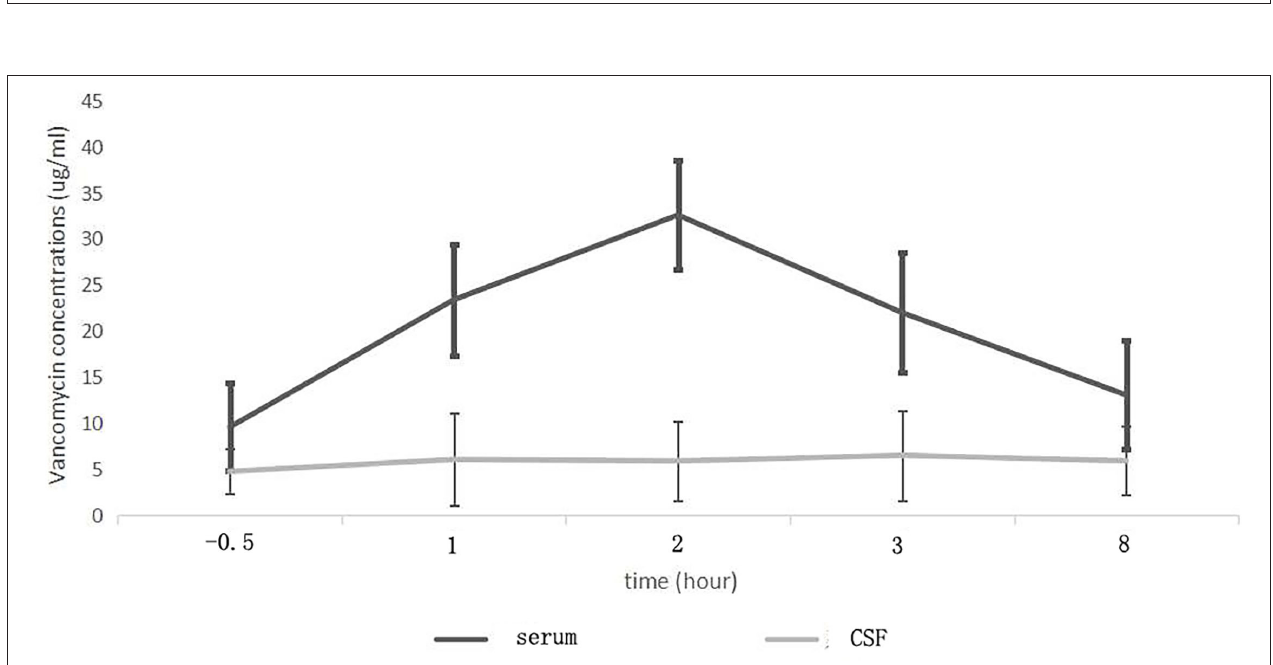
FIGURE 2 | Mean serum and cerebrospinal fluid (CSF) vancomycin concentration-time curves in patients with intracranial infection.